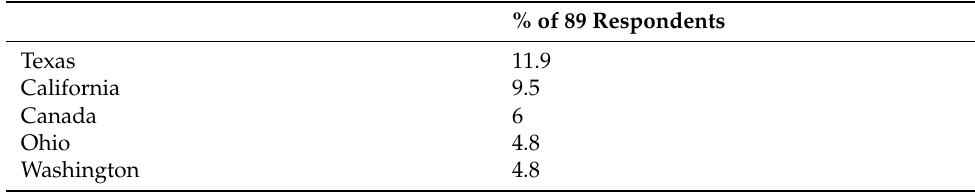
Table 2. Location of